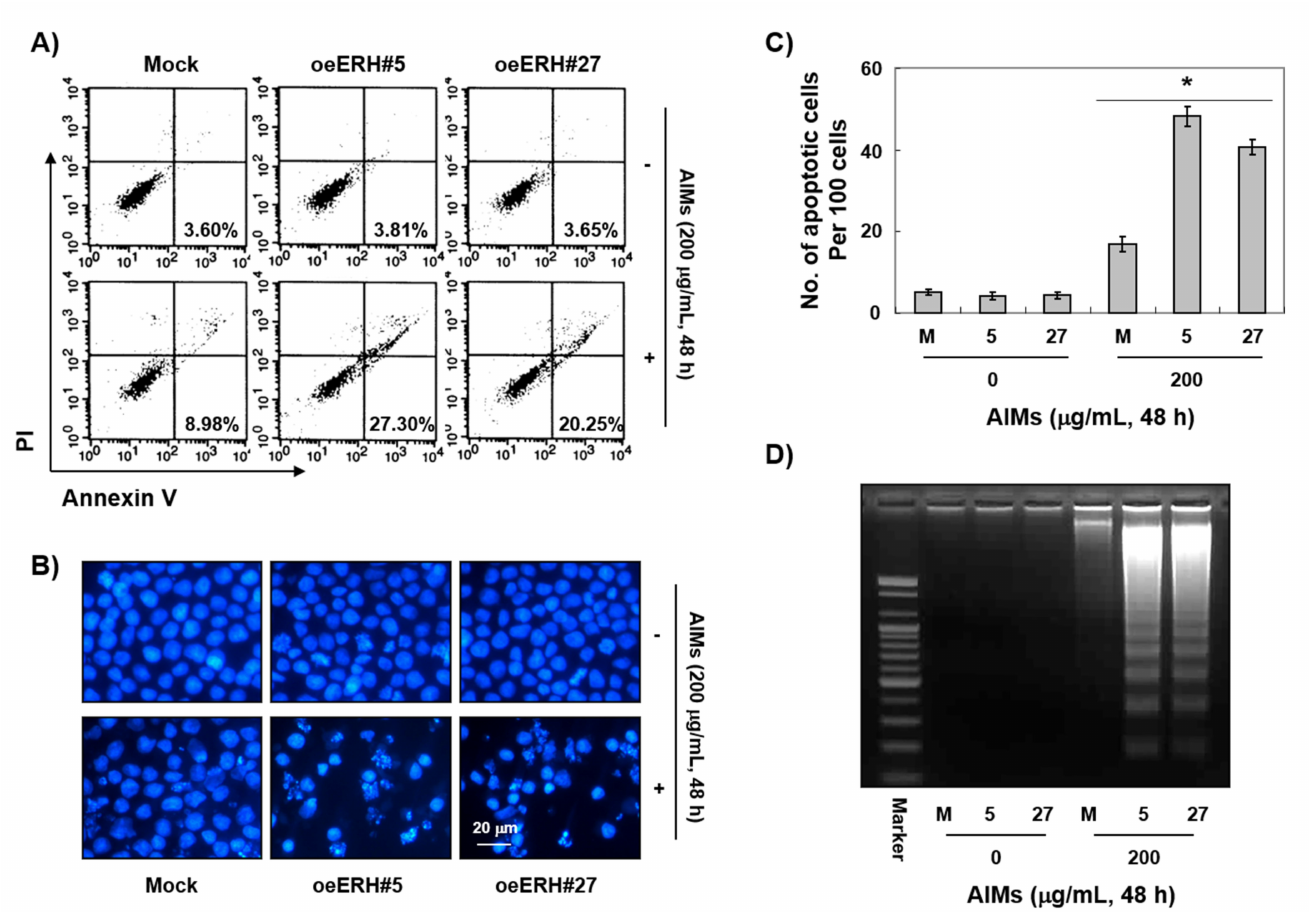
Figure 2. ERH-augmented apoptotic effects on AIM-treated MKN28 cells. The cells were seeded at the density of 5 × 10 4 cells per mL. The two kinds of E-MKN28 cells (eoERH#5 and eoERH#27) and M-MKN28 cells were treated with AIMs at the concentrations of 200 µ g/mL for 48 h. ERH increased the apoptotic effects of AIM on MKN28 cells. ( A ) Annexin V/PI flow cytometry assay, ( B ) nuclear staining with DAPI solution (Magnification, × 400), and ( C ) quantitative results for the number of apoptotic cells per 100 cells in total. * p < 0.05 vs. control group. ( D ) DNA fragmentation test. A ladder pattern of DNA fragmentation indicates internucleosomal cleavage associated with apoptosis. The data are representative of three independent experiments. M, M-MKN28 cells; 5, eoERH#5 E-MKN28 cells; 27, eoERH#27 E-MKN28